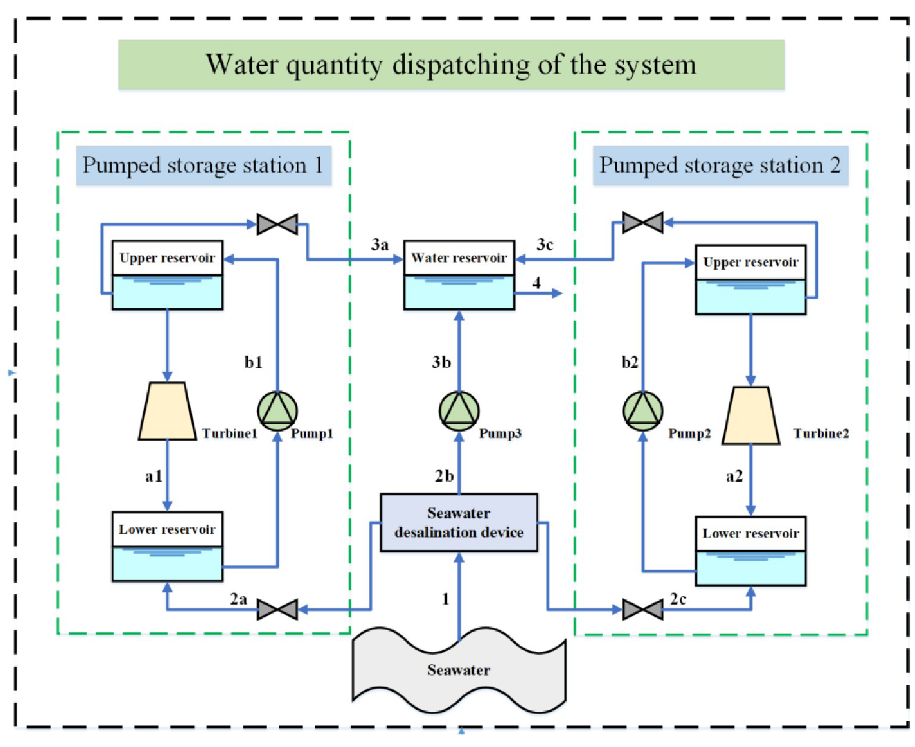
Fig 2. Framework of system water